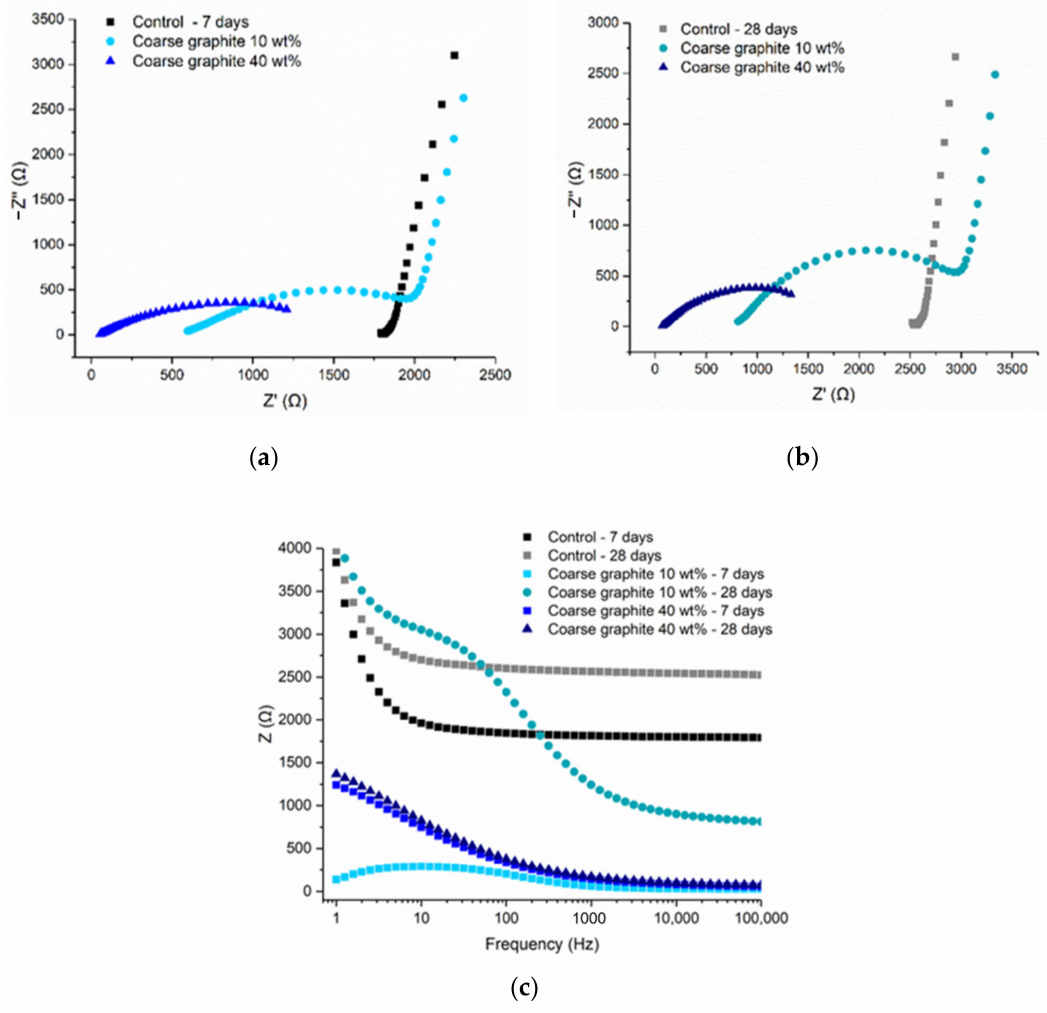
Figure 11. Cement paste with coarse graphite: ( a ) 7-day Nyquist plot, ( b ) 28-day Nyquist plot, and ( c ) frequency-dependent